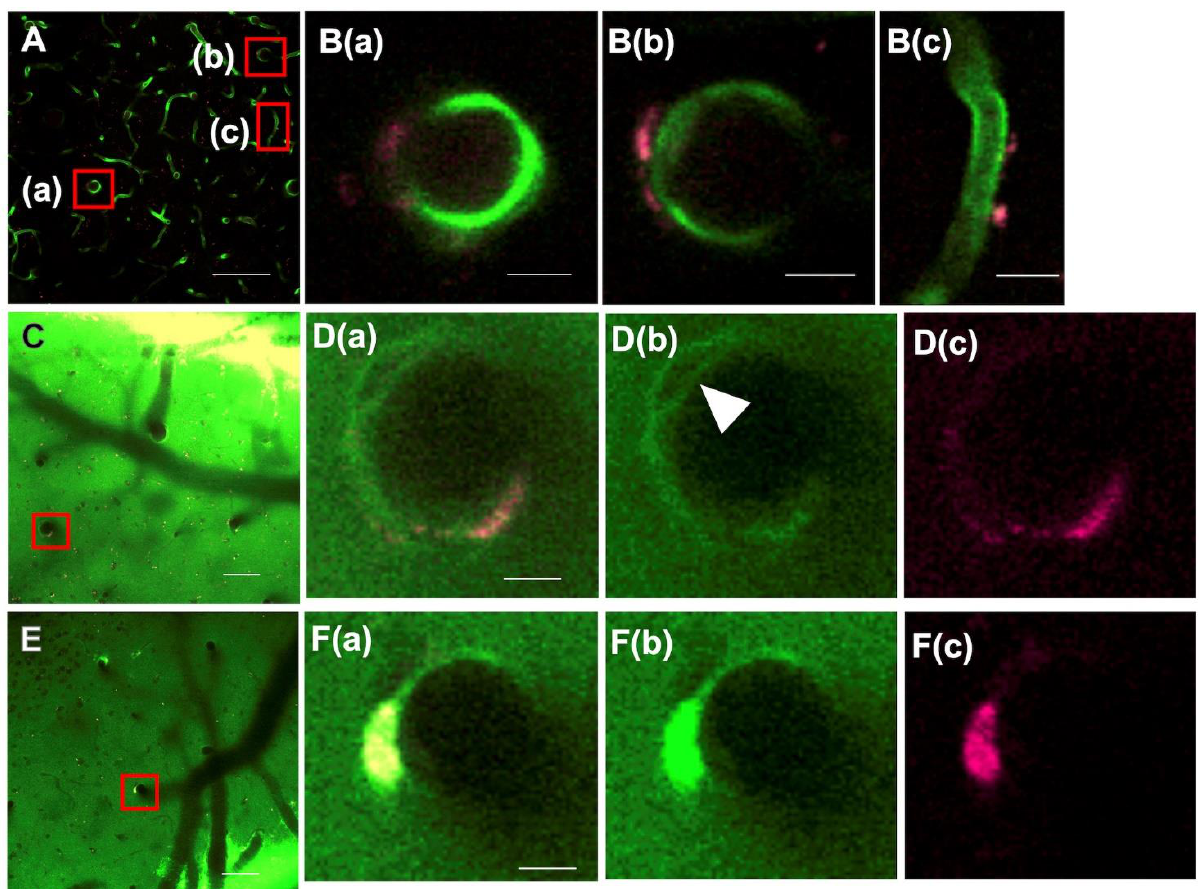
Figure 2. Distribution of tracers transported from the cortical surface. ( A , B ): The Hilyte Fluor 647- labeled A β 1–40 oligomer was found around a penetrating artery ( A ( a )), a penetrating vein ( A ( b )), and a capillary ( A ( c )) in a Tie2-GFP mouse. ( B ( a – c )) are enlarged images of red squares ( A ( a – c )), respectively. Notably, A β accumulated at only part of the vessel wall, not at the entire circumference, in all vessels observed. ( D ) enlarged from a red square in ( C ): FITC-dextran of 40 kD distributed over the entire circumference of a penetrating artery as well as in the parenchyma ( D ( b )). A double barrel was also observed (arrowhead). In contrast, the accumulation of A β oligomer was localized to part of the circumference ( D ( c )), which is evident in a merged image ( D ( a )). ( F ) enlarged from a red square in ( E ): Massive accumulation of A β fibrils was noticed at a penetrating vein ( F ( c )), whereas 40 kD dextran was distributed more widely ( F ( a , b )), a merged image of ( F ( b , c )). Scale bar: ( A , C , E ) 100 µ m; ( B , D , F ) 10 µ